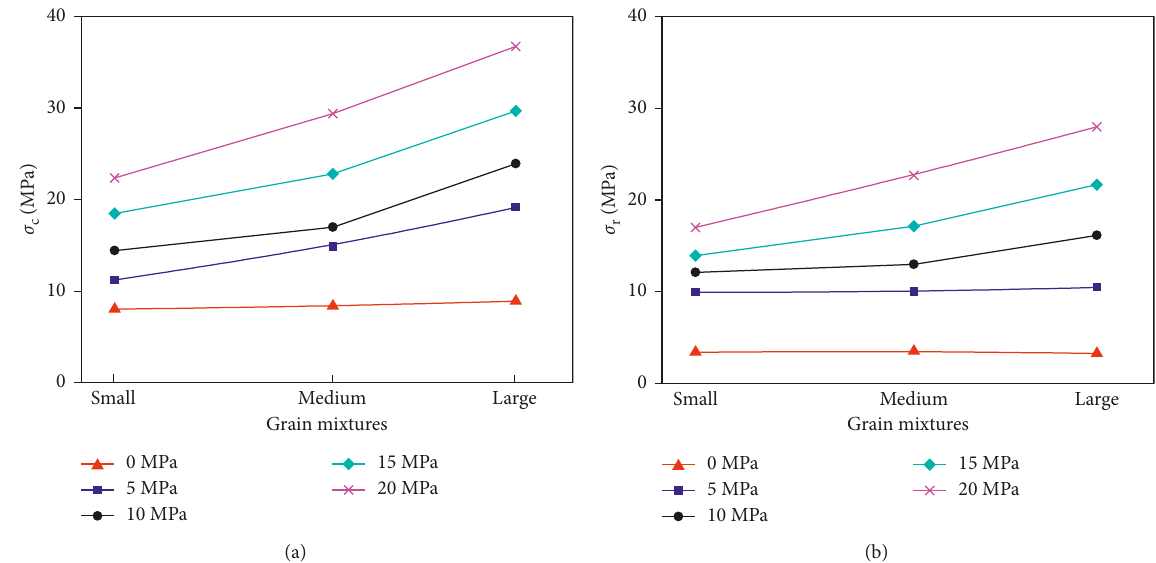
Figure 9: (a) Average values of peak strengths and (b) average values of residual strengths of different confining pressures versus the grouted specimens with different grain size mixtures.